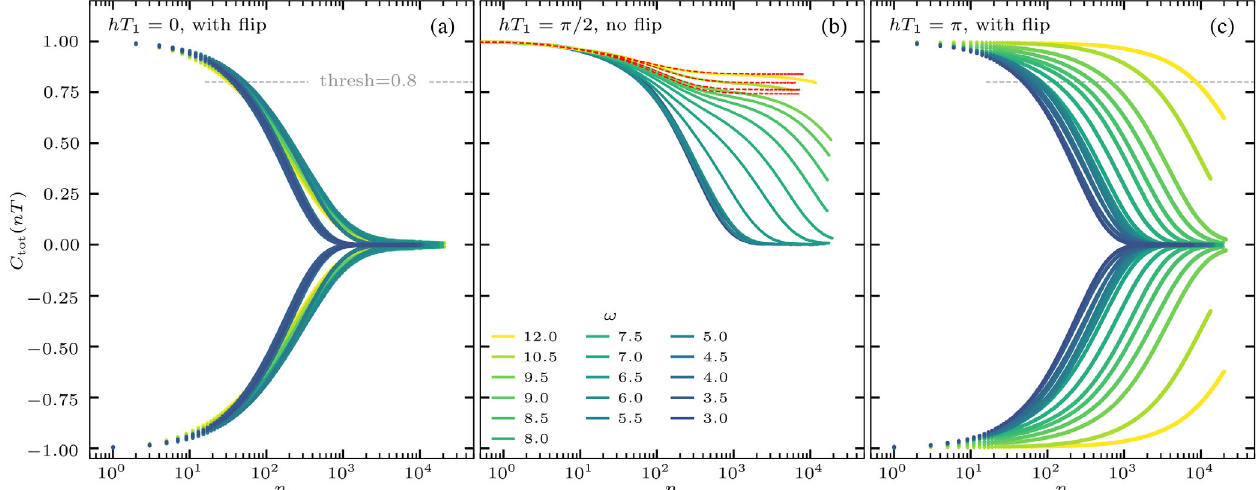
nT Þ [defined in Eq. (6)], stroboscopically observed, in a chain of length L ¼ 20 under FIG. 1. Survival of the total magnetization C tot ð the NMR Floquet drive for different driving frequencies ω ¼ 2 π =T 1 (3). The detuning of the spin rotation is ϵ ¼ 0 . 1 . (a) Without a field ( h ¼ 0 ) and with an approximate global flip P x θ , θ ¼ π þ ϵ , corresponding to the presumptive parameters of the NMR experiment, the magnetization dies off quickly with little dependence on the driving frequency. (b) At half the maximum field, h ¼ π = ð 2 T 1 Þ , and with θ ¼ 0 þ ϵ , the survival of the magnetization is enhanced. Dashed lines show the evolution with the time-averaged leading-order effective Hamiltonian. (c) With the maximal field h ¼ π =T 1 and with an approximate global spin flip θ ¼ π þ ϵ , we observe a prethermal time-crystalline signal with dramatically enhanced lifetime, by more than 100 × compared to (a). The lifetime shows an exponential dependence on driving frequency (Fig. 2), a hallmark of